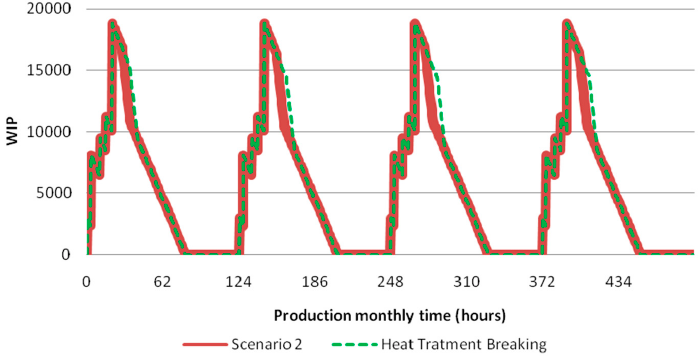
Figure 11. Hypothetical machine breaking situation, as presented preliminarily in Reference [23].